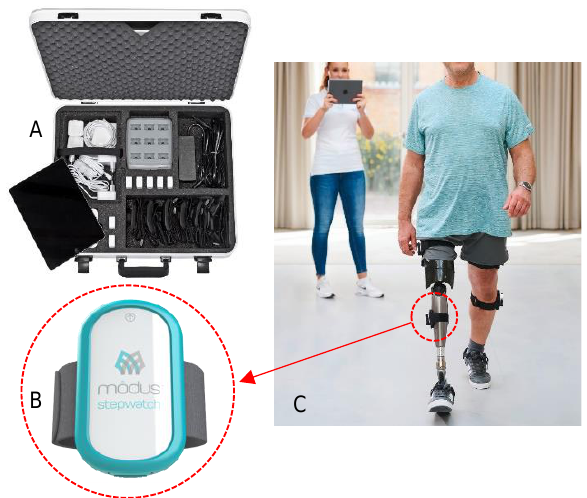
Figure 4: Real real-time sensors to aid in data capture, developed specifically for orthotics and prosthetics are used at Ability as part of daily clinical practice. A : Ottobock Bionic Pro; B :ModusTM StepWatch; C : Real-time, untethered gait analysis being carried